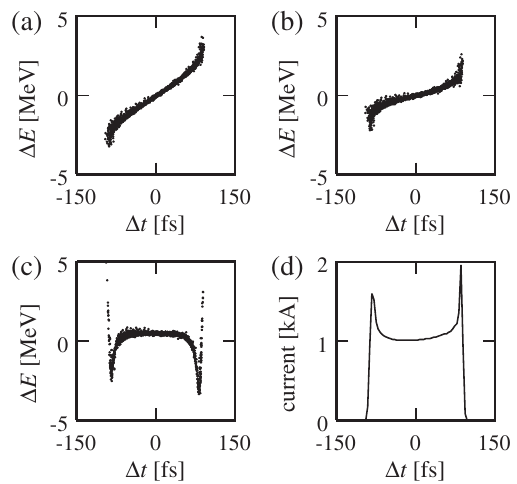
FIG. 2. Evolution of longitudinal phase space after bunch compression. The bunch tail is on the right. (a) Chirped bunch at the exit of the bunch compressor, at beam energy of 400 MeV. (b) Bunch with reduced chirp at the linac exit where the beam energy is 1.7 GeV. (c) Dechirped bunch at the exit of the beam spreader at beam energy of 1.7 GeV. (d) Current distribution of the longitudinally frozen bunch, evaluated at the exit of the beam